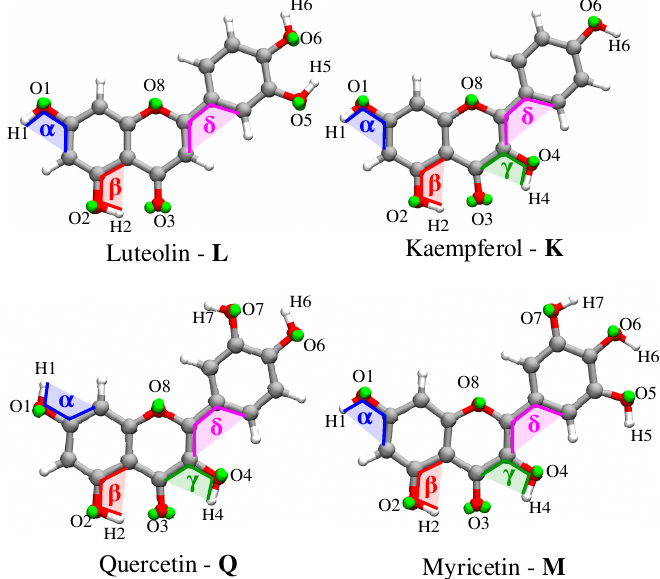
Figure 2. Atom labeling and definition of dihedral angles and oxygen virtual sites for the four